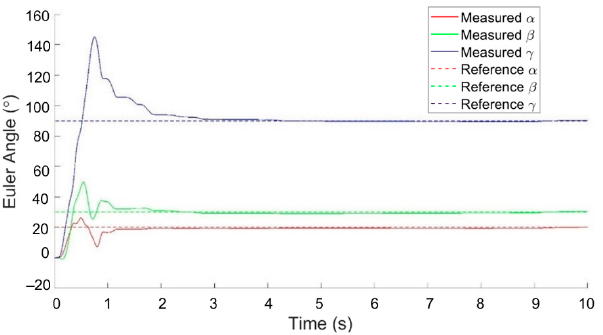
Figure 14. Experimental closed-loop results: typical PID responses for step references in α , β and γ angles. Separate testing was conducted to track time-varying references about multiple axes.